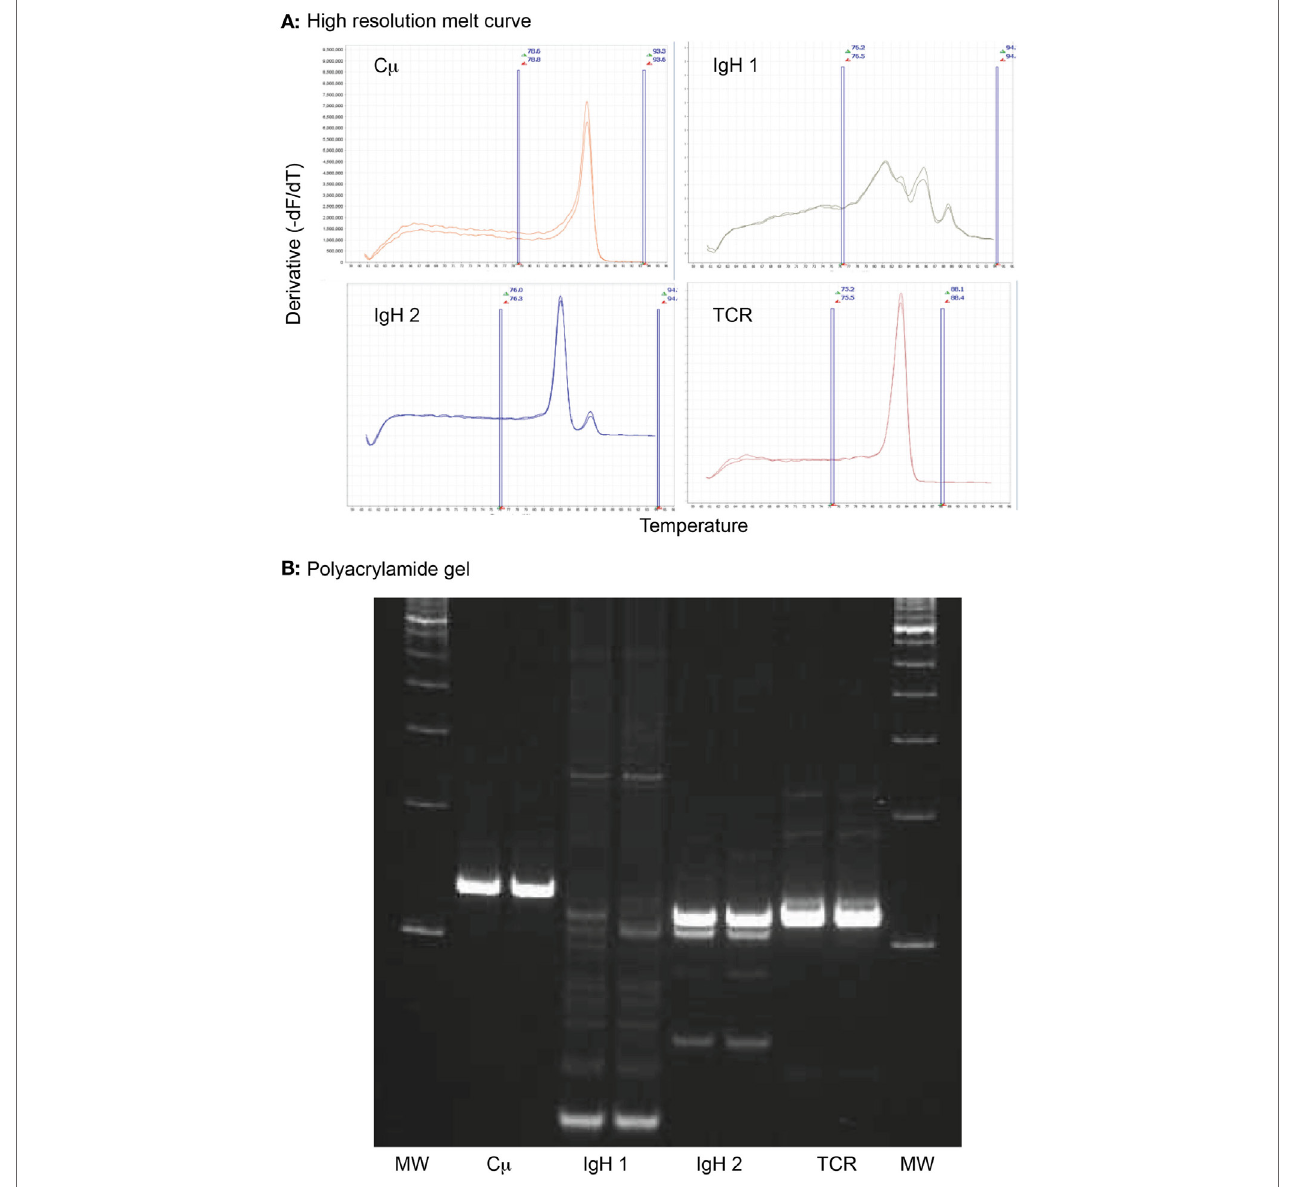
FigUre 3 | high-resolution melt curve analysis of amplified Dna products retrieved from an archived venous blood smear of a dog with acute myeloid leukemia (case 1) . (a) Sharp peaks in the negative derivative curves yielded from the normalized DNA melt curve showed that the tumor cells had clonal rearrangements in complementarity-determining region 3 (CDR3) of the immunoglobulin heavy chain with primer set 2 (IgH 2) and the CDR3 of T cell gamma receptor (TCR), i.e., a biclonal rearrangement. The multiple broad peaks with the first primer set for the CDR3 of the immunoglobulin heavy chain (IgH 1) is compatible with a polyclonal product. The positive control (C μ ) yielded the expected single peak. All reactions were run in duplicate. Note that all curves have the same Y- and X-axis. The area between the vertical blue lines represent the active melt curve region, in which the calculations are performed. (B) A 10% polyacrylamide gel was performed on the sample to verify the results of the high-resolution melt curve analysis. This showed a broad smear (polyclonal) with primer set 1 for the heavy chain CDR3 (IgH 1), a strong clonal band with primer set 2 for the heavy chain CDR3 (IgH 2), and a strong single clonal band with the T cell gamma receptor CDR3 primer set (TCR). The positive control (C μ ) yielded a single strong product, as expected. All reactions were run in duplicate. MW represents the molecular weight marker (100 base pair